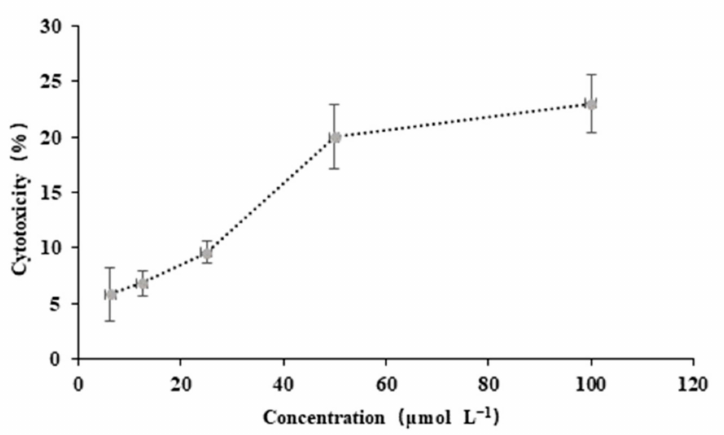
Figure 10. The cytotoxicity of RCya on HeLa at 24 h.